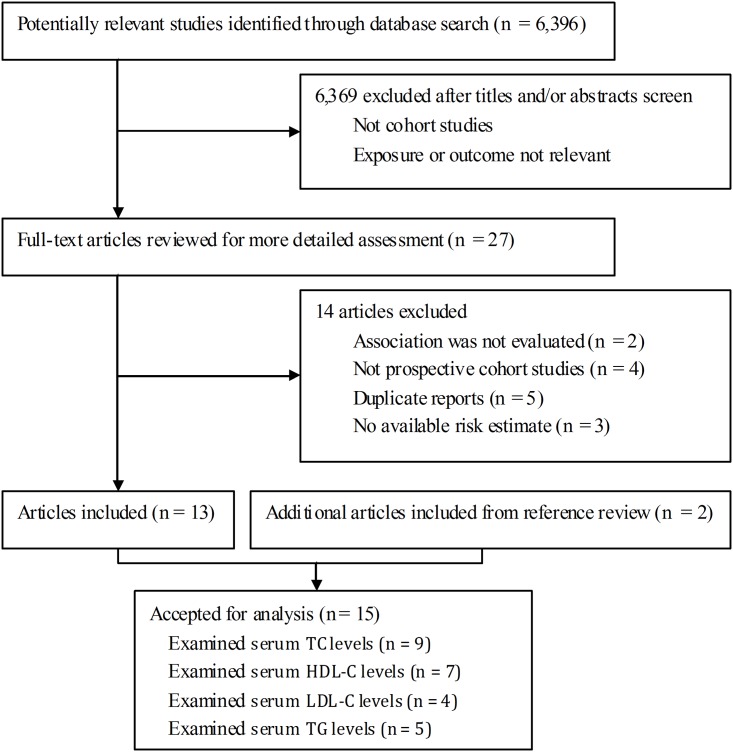
Flow diagram of study selection.Flow chart shows literature search and selection for prospective cohort studies of serum lipids in relation to breast cancer risk. TC = total cholesterol; HDL-C = high-density lipoprotein cholesterol; LDL-C = low-density lipoprotein cholesterol; TG = and triglycerides.